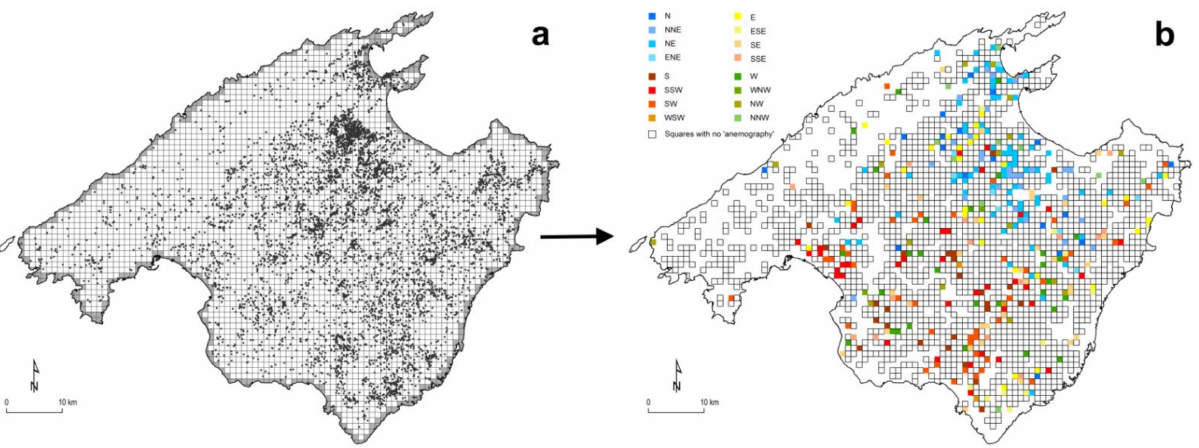
Figure 11. ( a ) Distribution of threshing floors (black dots, n = 5890) on a chequered mesh with a resolution of 1000 × 1000 m; ( b ) Squares containing threshing floors and resulting wind-direction assigned to each threshing floor (experimental basis, n =